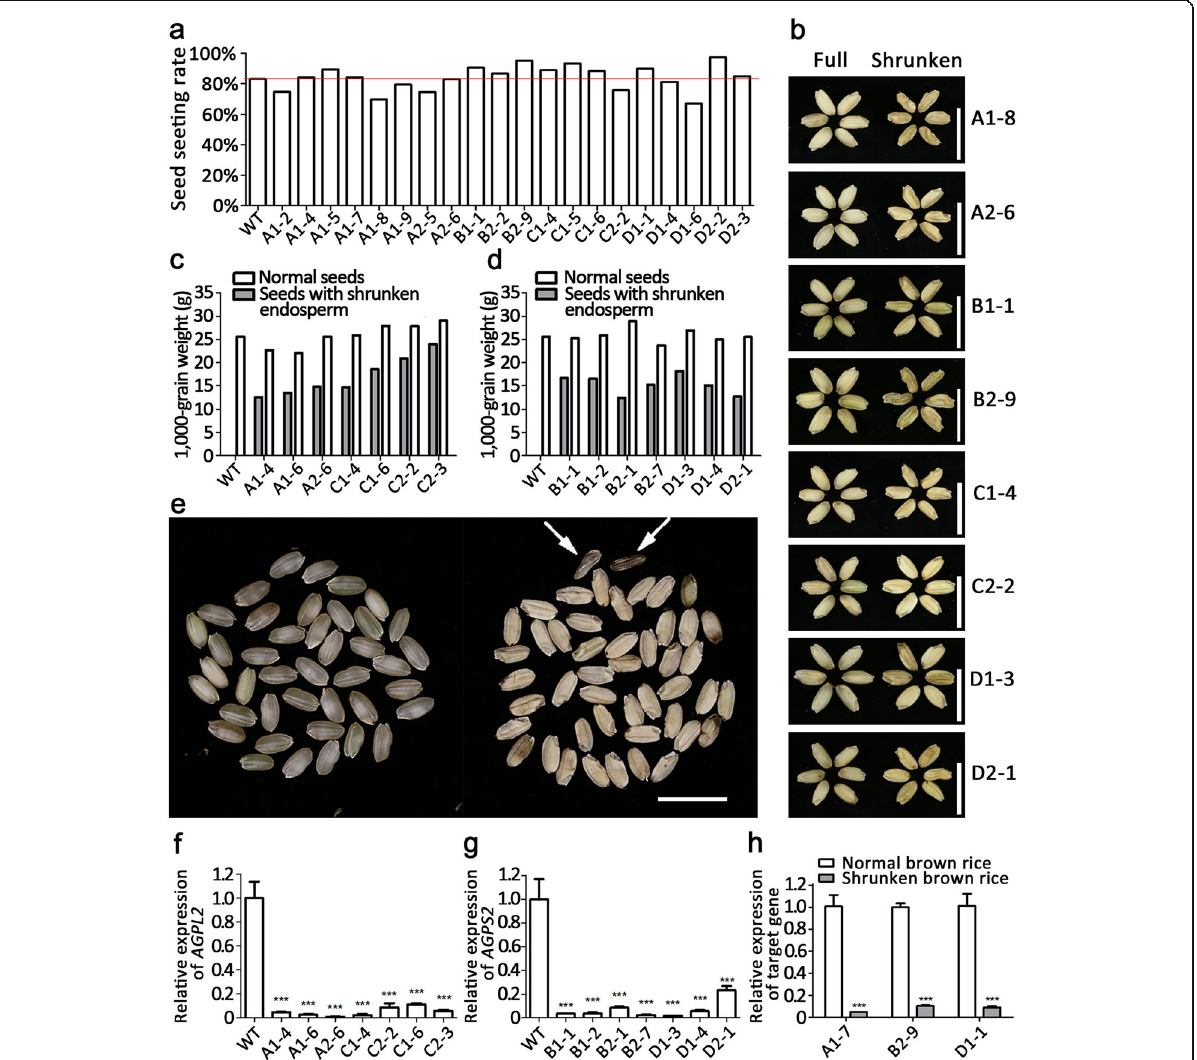
Fig. 3 The morphology and weight of seeds from T 0 transgenic plants. ( a ) The seed setting rates of the individual T 0 transgenic plants. ( b ) The de-hulled grains from eight T 0 transgenic plants. Grains with normal endosperm and grains with shrunken endosperm are shown. ( c, d ) 1000- grain weight of seeds from T 0 transgenic plants silencing OsAGPL2 ( c ) and OsAGPS2 ( d. ) The seeds from each individual T 0 plant were sorted by a weight sorter into the heavy-weight and light-weight groups. The 1000-grain weight was measured for each group. ( e ) The de-hulled heavy and light grains from A1-4. The arrows indicate two molded grains. ( f-h ) The OsAGPL2 and OsAGPL2 mRNA levels in the light and heavy seeds from the corresponding gene-silencing plants. The OsAGPL2 and OsAGPS2 transcript levels in the light seeds were compared with that in the wild type seeds ( f, g ) or that in the heavy seed ( h ). The transcript levels were determined using qRT-PCR with the ubiquitin gene as internal control. Data are shown as means ± SD (n = 3). Bar: ( b, e ) = 1